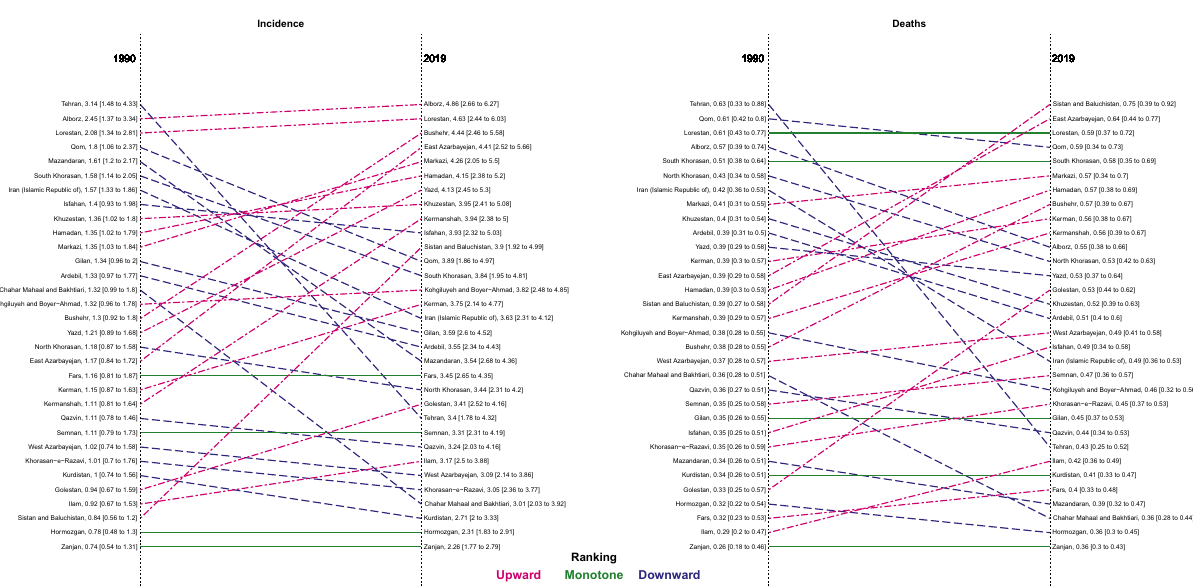
Figure 3. The age-standardized incidence and deaths of thyroid cancer in provinces of Iran ( A : 1990, B : 2019), Republished from https:// www. opens treet map. org/ under a CC BY license, with permission from https:// www. opens treet map. org/ copyr ight, original copyright 2022.